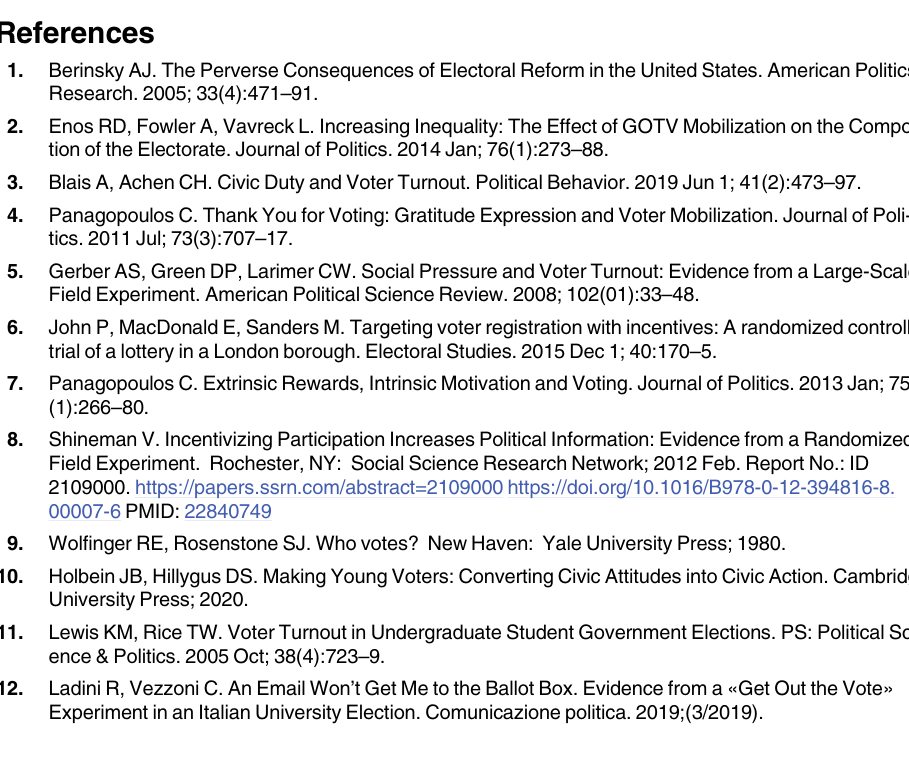
S3 Table. Turnout and candidates for UMass student government elections, 2019–2022. S1 Fig. Public opinion on a lottery compared to other financial incentives/penalties.